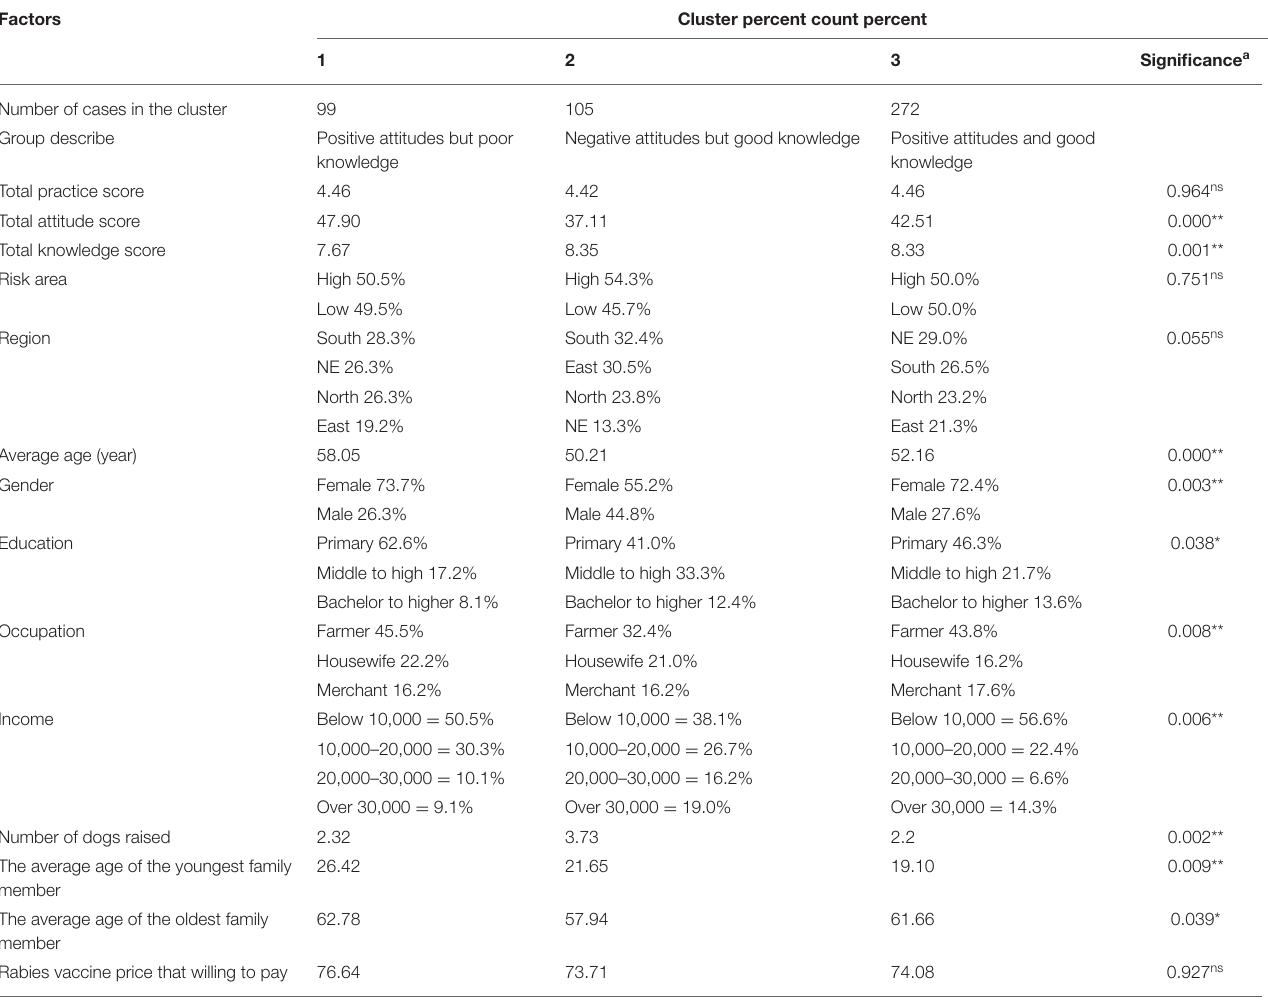
TABLE 6 | KAP score clusters to describe socioeconomic status of dog owners regarding rabies control in Thailand.